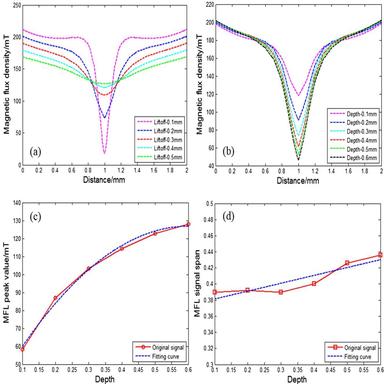
MFL signals and characterizations of rectangular defect; (a) MFL signals of rectangular defect in different liftoff values with the depth of 0.3 mm; (b) MFL signals of rectangular defect in different depths with the liftoff of 0.2 mm; (c) Relationships between MFL peak values in (b) and rectangular defect depths; (d) Relationships between MFL signal spans in (b) and rectangular defect depths.